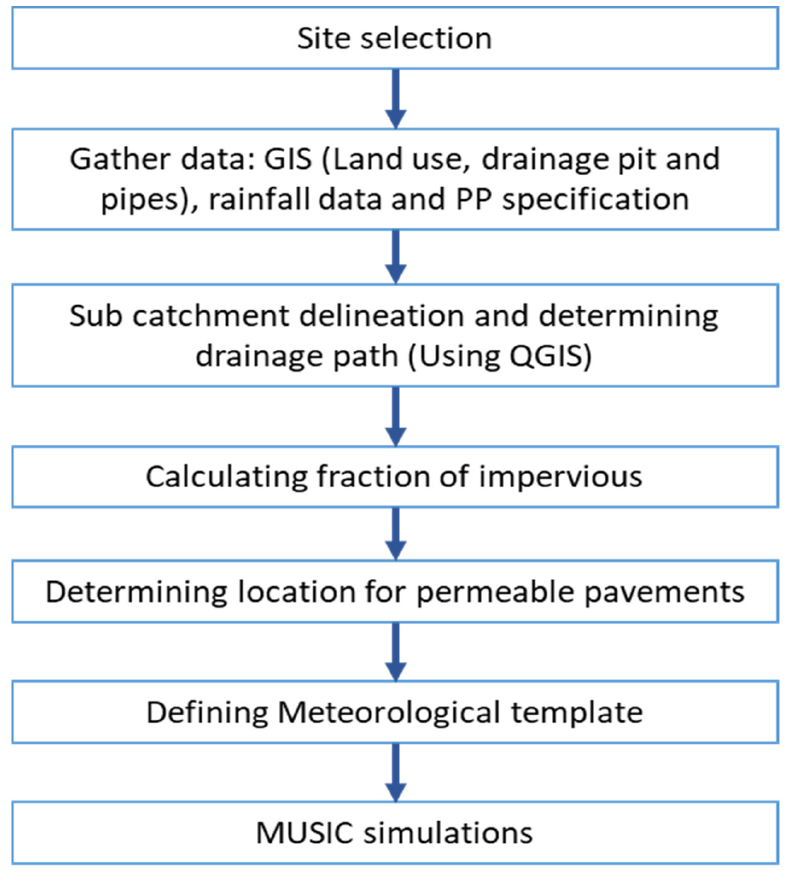
Figure 1. Flow chart of the methodology.